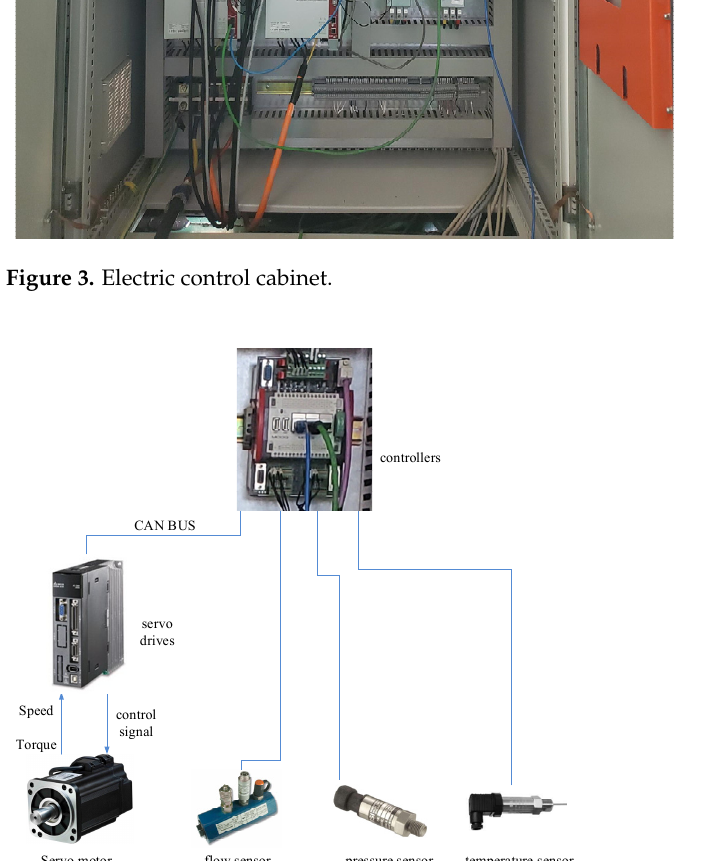
Figure 4. Schematic diagram of electrical framework.